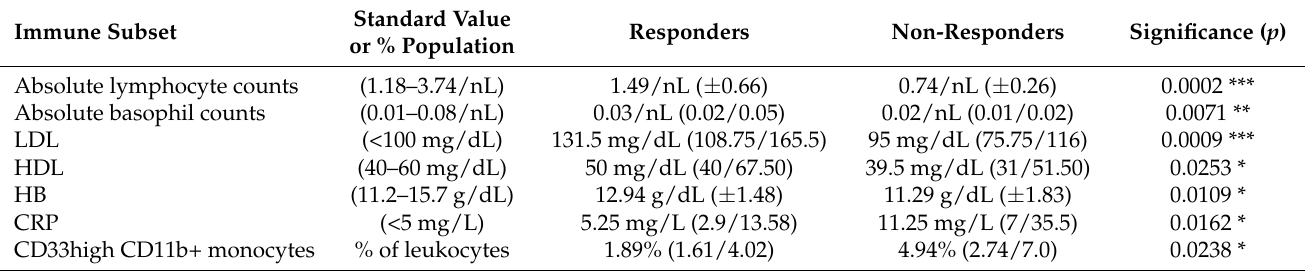
Table 2. Already familiar target analytes in immunotherapy.